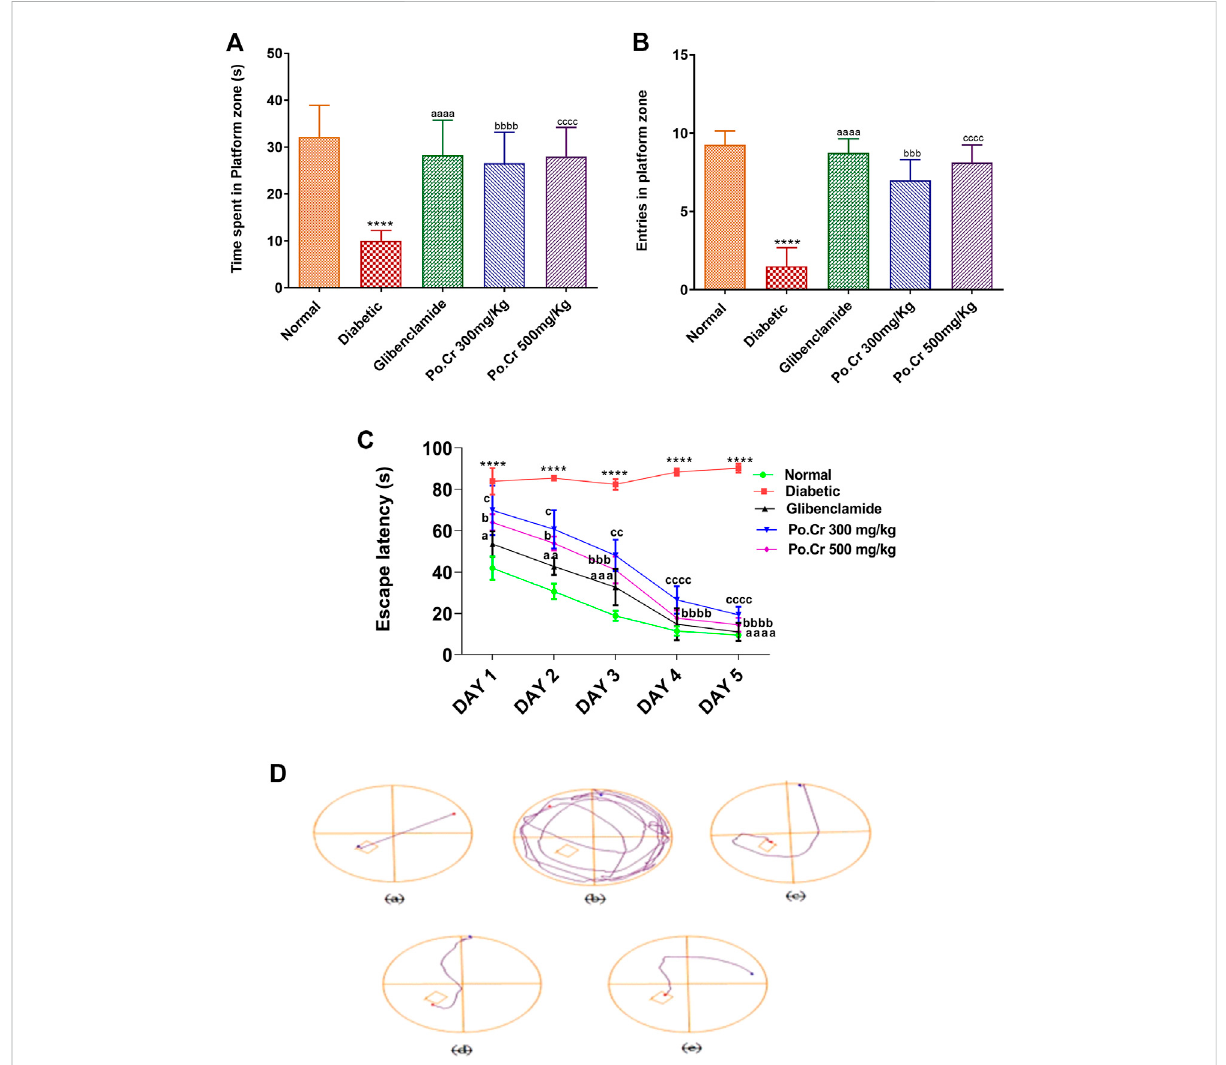
FIGURE 2 Representation oftheeffectsofcrudemethanolic extractof Plumeria obtusa on theperformance ofdiabetic ratsintheMorris water mazetest. (A) Time spent in platform (SW) zone, (B) entries into platform (SW) zone, (C) escape latency, and (D) swim paths taken by rats to the hidden platform in the SW zone. Group II (diabetic control) was compared to Group I (normal control), whereas all the treated groups (Groups III [glibenclamide] to V [Po.Cr]) were compared with Group II (diabetic control). ANOVA (two-way) and the multiple comparison Dunnett ’ s test were applied, and the data values are mean ± SEM. * p < 0.05 indicates comparison of diabetic control (Group II) to normal control (Group I), whereas a p < 0.05, b p < 0.05, and c p < 0.05 indicate comparison of glibenclamide (Group III); Po.Cr, 300 mg/kg (Group IV); and Po.Cr, 500 mg/kg (Group V) versus the diabetic control group,